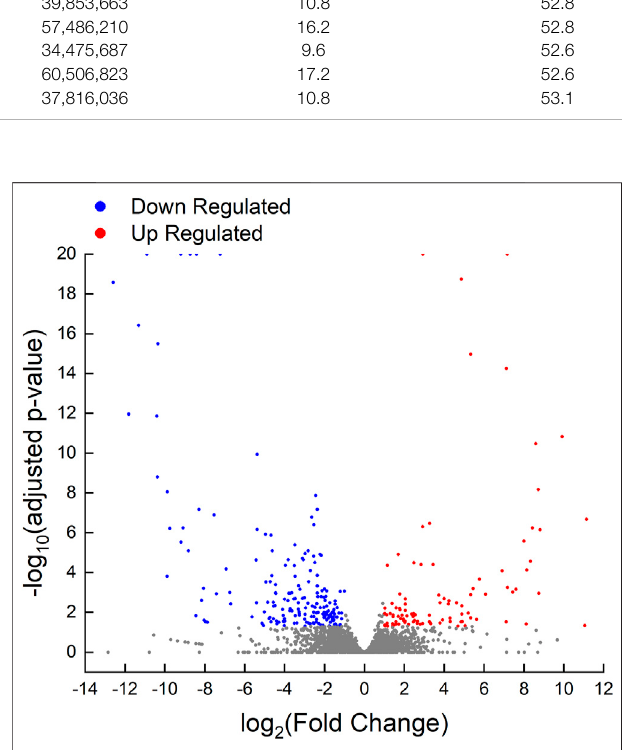
FIGURE 5 | Volcano plot of differentially expressed genes in control fi sh and testis-removed fi sh. To fi nd the genetic information during secondary sex determination, we performed differential expression analysis in the control fi sh and testis-removed fi sh with DESeq2. Genes with “ adjusted p-value < of unigenes hits 0.05 ” and “ |log 2 Fold Change| > 1 ” were considered the DEGs (differentially expressed genes). The up-regulated (101 genes) and down-regulated (188 genes) DEGs in testis-removed fi sh were shown in red and blue dots, respectively. The gray dots represented the genes not belonging to